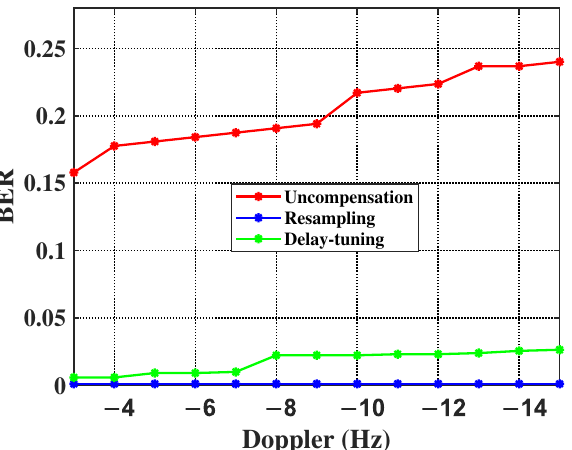
Figure 14. The BER outputs of different communication schemes under different Doppler conditions for sea experimental data.